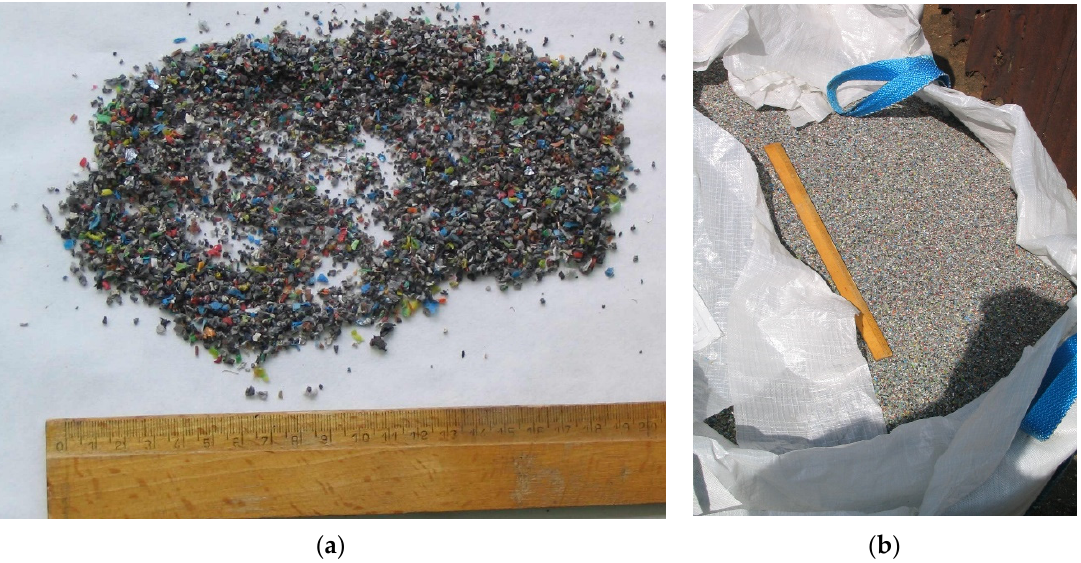
Figure 2. Waste material used to produce the LCF (( a ) particle size and structure; ( b ) transport and storage container).